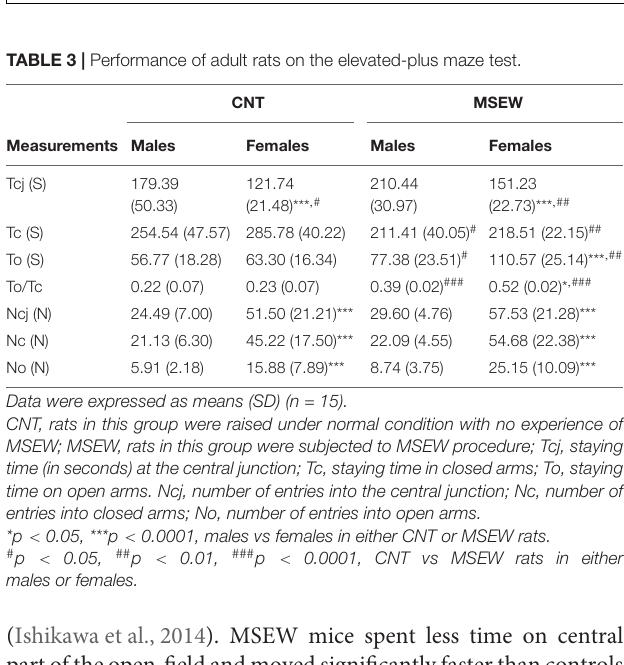
FIGURE 4 | Performance of rats in social interaction test. (A) The comparisons between the E session and C session, in terms of the time spent on interaction zone. (B) The comparisons between males and females in either CNT or MSEW rats, in terms of the time spent on interaction zone. (C) The comparisons between CNT and MSEW rats in either gender, in terms of the time spent on interaction zone. Data were expressed as mean ± SD. n = 15/group. * p < 0.05, ** p < 0.01, *** p < 0.001.